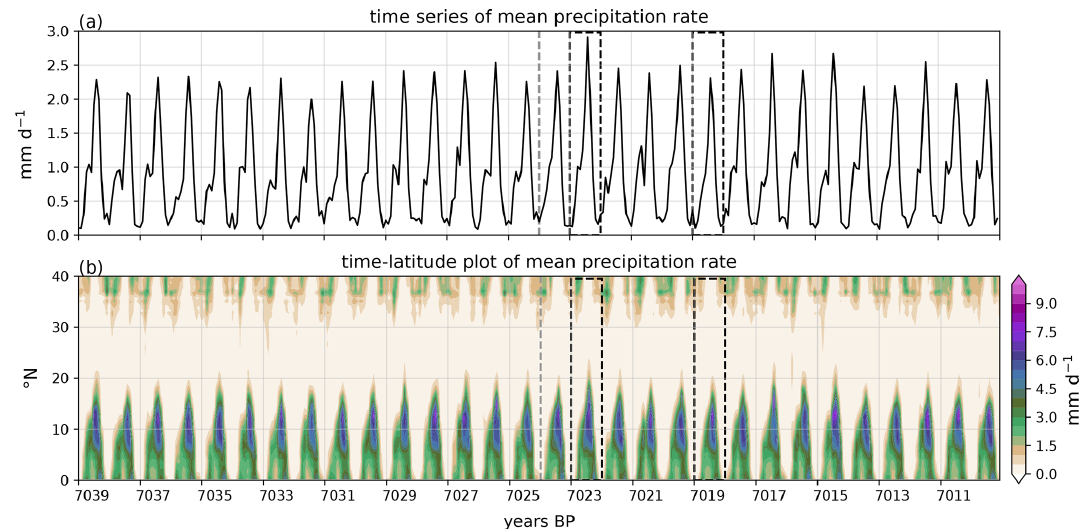
Figure 2. The 30-year time series of the mean precipitation rate (a) and the latitude–time plot of the mean precipitation rate over land (b) indicating the northward extension of the WAM every year for the whole 5km domain spanning the area from 0–40 ◦ N and from 37 ◦ E– 53 ◦ W. The dashed light-gray line indicates the end of the spinup phase when soil moisture is on a constant level. The dashed rectangles show the years we chose for our analysis: 7023BP (strong) and 7019BP